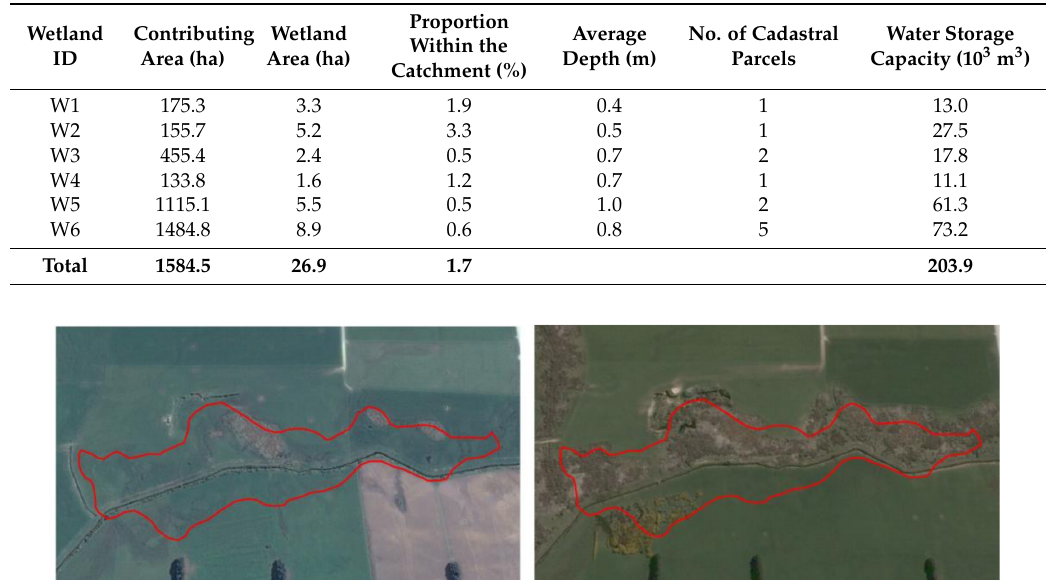
Table 1. Main characteristics of the six potential wetlands identified in the present analysis. Figure 6 shows the areas of these wetlands for different flood depths, and Figure 7 shows their locations within the catchment.